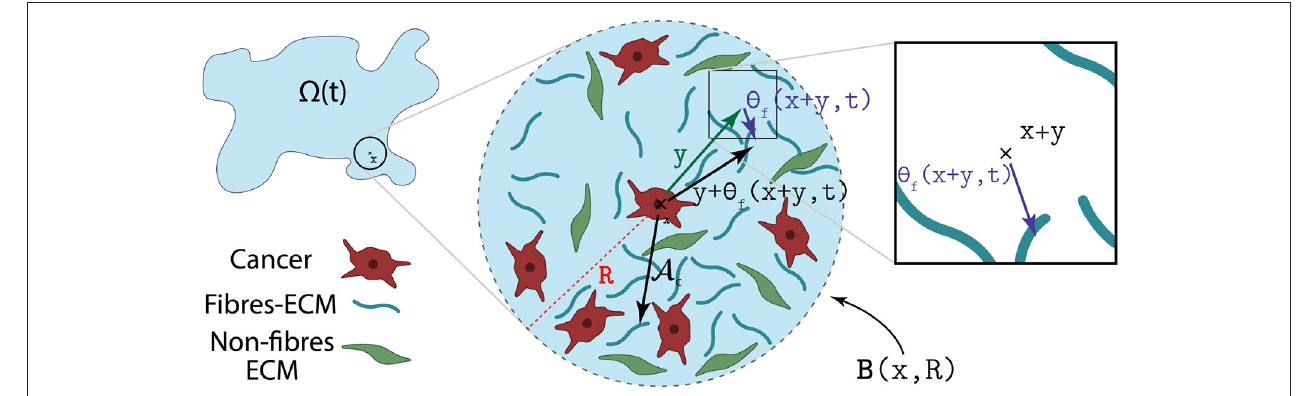
FIGURE 3 | Illustration of how the orientation of the fibres θ f ( · , · ) biases the cell-fibre